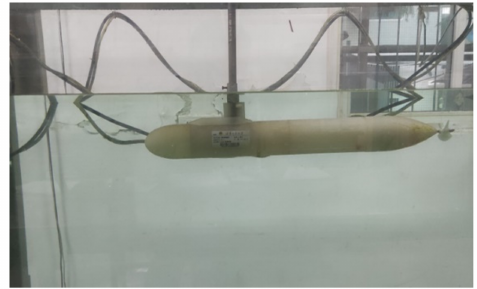
Figure 14. Model of the underwater